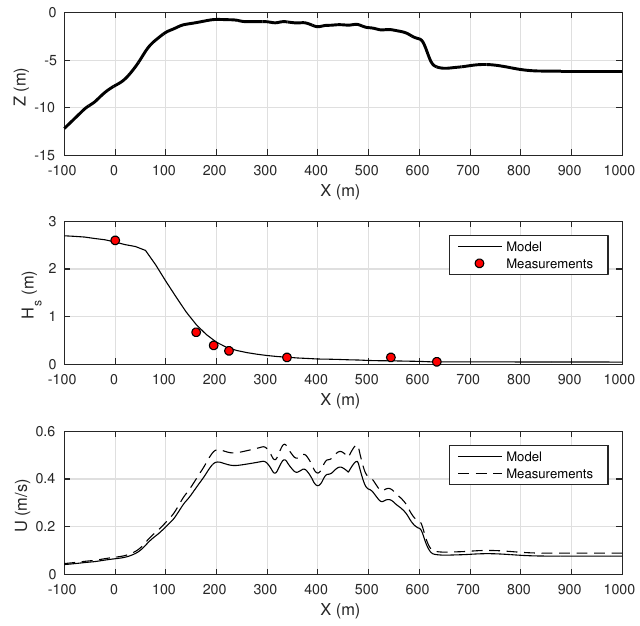
Figure 1. Confrontation between numerical prediction and in situ measurements on the Ouano barrier reef, New Caledonia. Waves are coming from the open ocean, at the left side. Top panel: bed elevation. Middle panel: cross-shore profile of significant wave height. Bottom panel: cross-shore profile of depth-averaged